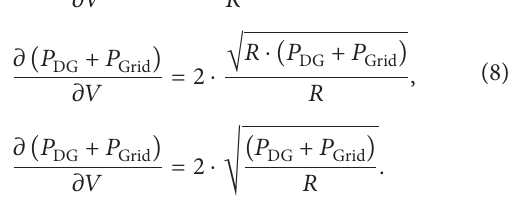
Figure 11: Speed of over/undervoltage islanding detection method.